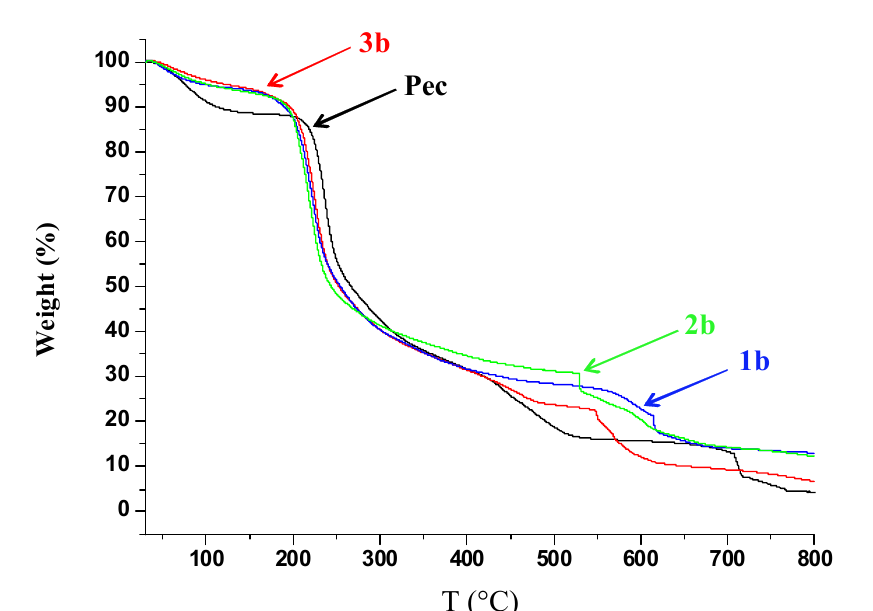
Figure 4. The loss of weight of the pristine and modified pectin samples 1b , 2b , and 3b as a function of